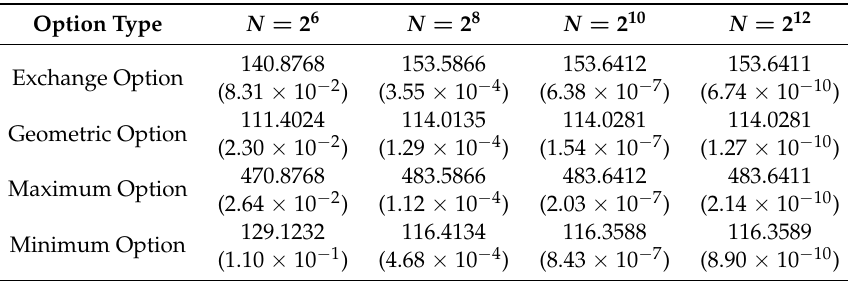
Table 8. Approximation results for 2D